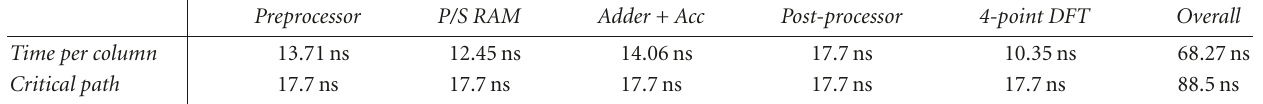
Table 8: Critical path of the basic calculation module in the BDA architecture.